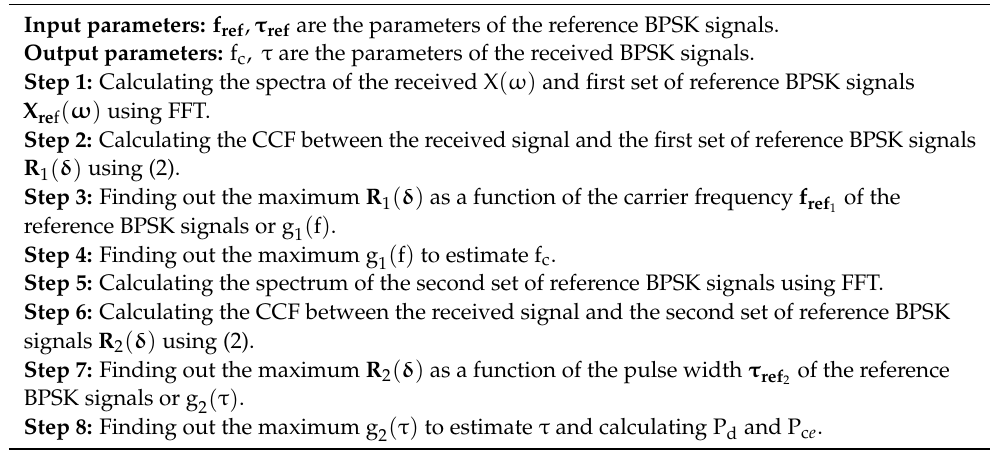
Algorithm 1 Steps of the proposed method